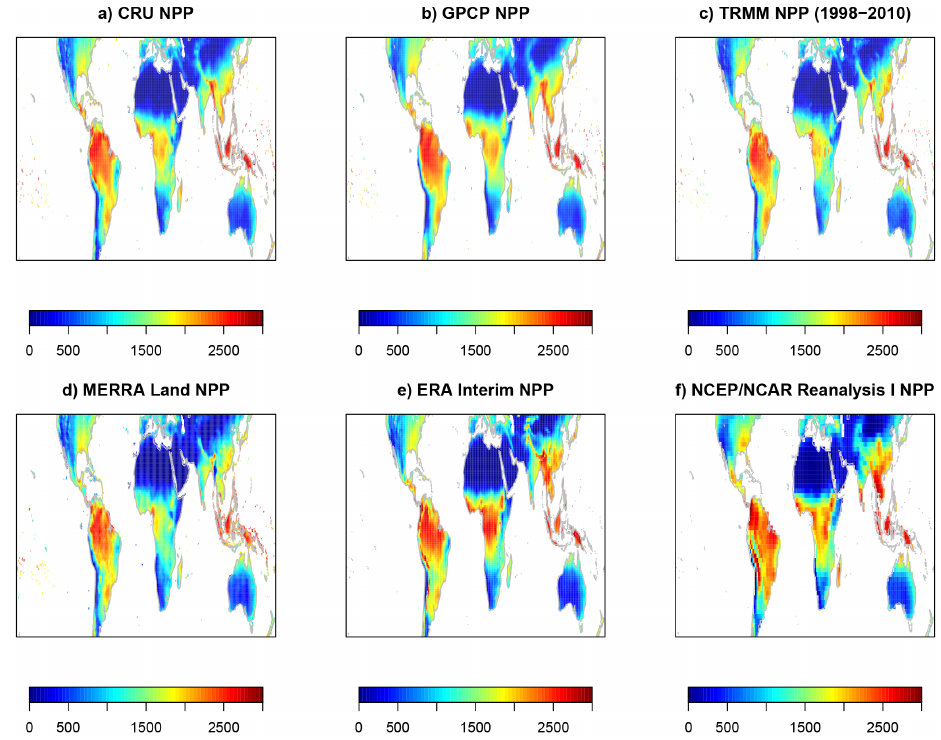
Figure 2. Spatial distribution of mean potential rainfall limited NPP fields derived from Lieth’s model (Fig. 1). (a) Mean annual precipitation limited NPP for 1982–2010 from CRU data. (b) NPP for GPCP data, (c) NPP for TRMM 3B43 data, average calculated over 1998–2010, (d) NPP for MERRA Land reanalysis, (e) NPP for ERA Interim reanalysis and (f) NPP for NCEP/NCAR Reanalysis